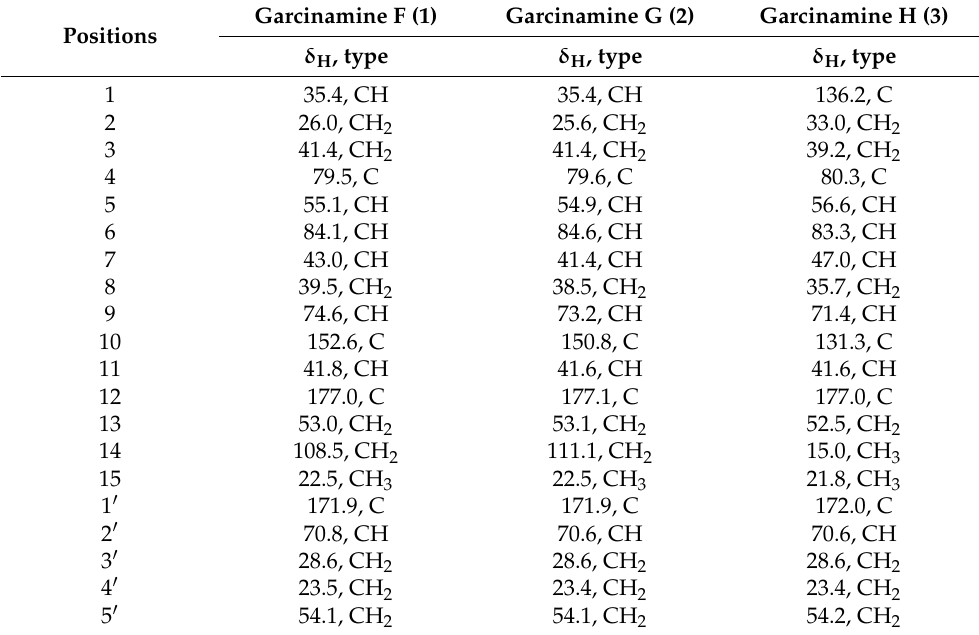
The 1 H NMR spectrum of garcinamine F (Table 2) showed signals for a methyl singlet ( δ H 1.33), two exomethylene sp 2 protons ( δ H 5.17 and 5.51), two oxymethine protons ( δ H 3.99 and 4.23), and two downfield methylene protons ( δ H 3.53/3.63 and 3.25/3.86). The